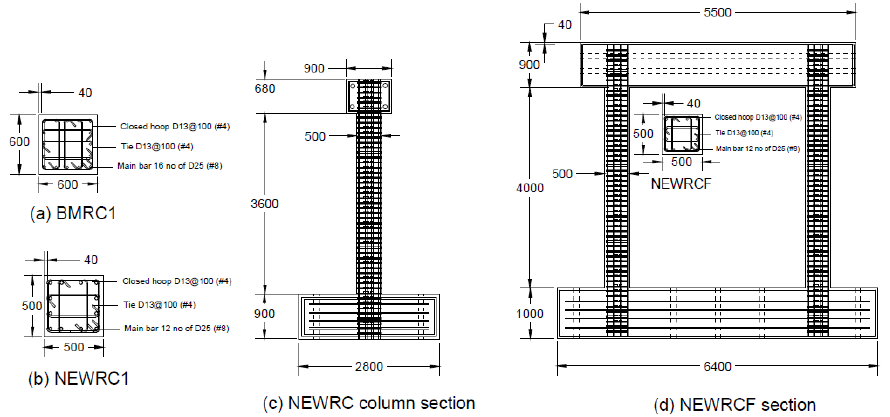
Figure 1. Section details for the BMRC1, NEWRC columns, and NEWRCF. Unit: mm. On the other hand, specimens NEWRC1, NEWRC2, NEWRC3, NEWRC4, and NEWRC5 are composed of high-strength materials, have a square cross-section of 500 mm × 500 mm, and are reinforced with 12 D25 (No. 8) longitudinal bars and transversely reinforced with D13 (No. 4) crossties and 135-degree seismic hooks. The clear height of all the column specimens is 3600 mm, while the thickness of the concrete cover is 40 mm. The longitudinal reinforcement ratio for BMRC1 was 2.26%, whereas, for all the NEWRC columns, it was 2.44%. Although the longitudinal reinforcement ratio between BMRC1 and NEWRC columns is similar, the cross-sectional area and longitudinal rebar vary. Due to this, specimen NEWRC1 has a 30.5% reduction in column cross-sectional area, 25% reduction in longitudinal reinforcement area, and 35.7% reduction in the transverse reinforcement area compared with specimen BMRC1. The primary objective of having different specifications for BMRC1 and NEWRC1 is to investigate whether a similar force-deflection response can be achieved with the reduced cross-sectional area, longitudinal reinforcement area, and transverse reinforcement area. The experimental parameters used for determining the seismic behavior of the NEWRC columns are the spacing of the transverse reinforcements, the axial load ratio, and transverse reinforcement strength. In this study, the amount of transverse reinforcement for BMRC1 was 1.08%, while for NEWRC columns, it ranged from 0.344% to 1.03%. The transverse reinforcements’ spacing was kept at 100 mm for BMRC1, NEWRC1, NEWRC4, and NEWRC5, which is less than five times the diameter of the longitudinal bars. However, for NEWRC2 and NEWRC3, the transverse reinforcement spacings were increased to 200 and 300 mm, respectively, which is higher than five times the diameter of the longitudinal bars. In the literature, premature bar buckling has often been identified as the main factor for the failure of the high-strength column [30]. In this view, the results from NEWRC1, NEWRC2, and NEWRC3 will provide an insight into the influence of transverse spacing on the high-strength columns’ seismic